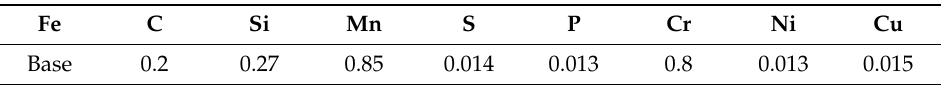
Table 1. Chemical composition (wt %) of 20CrH